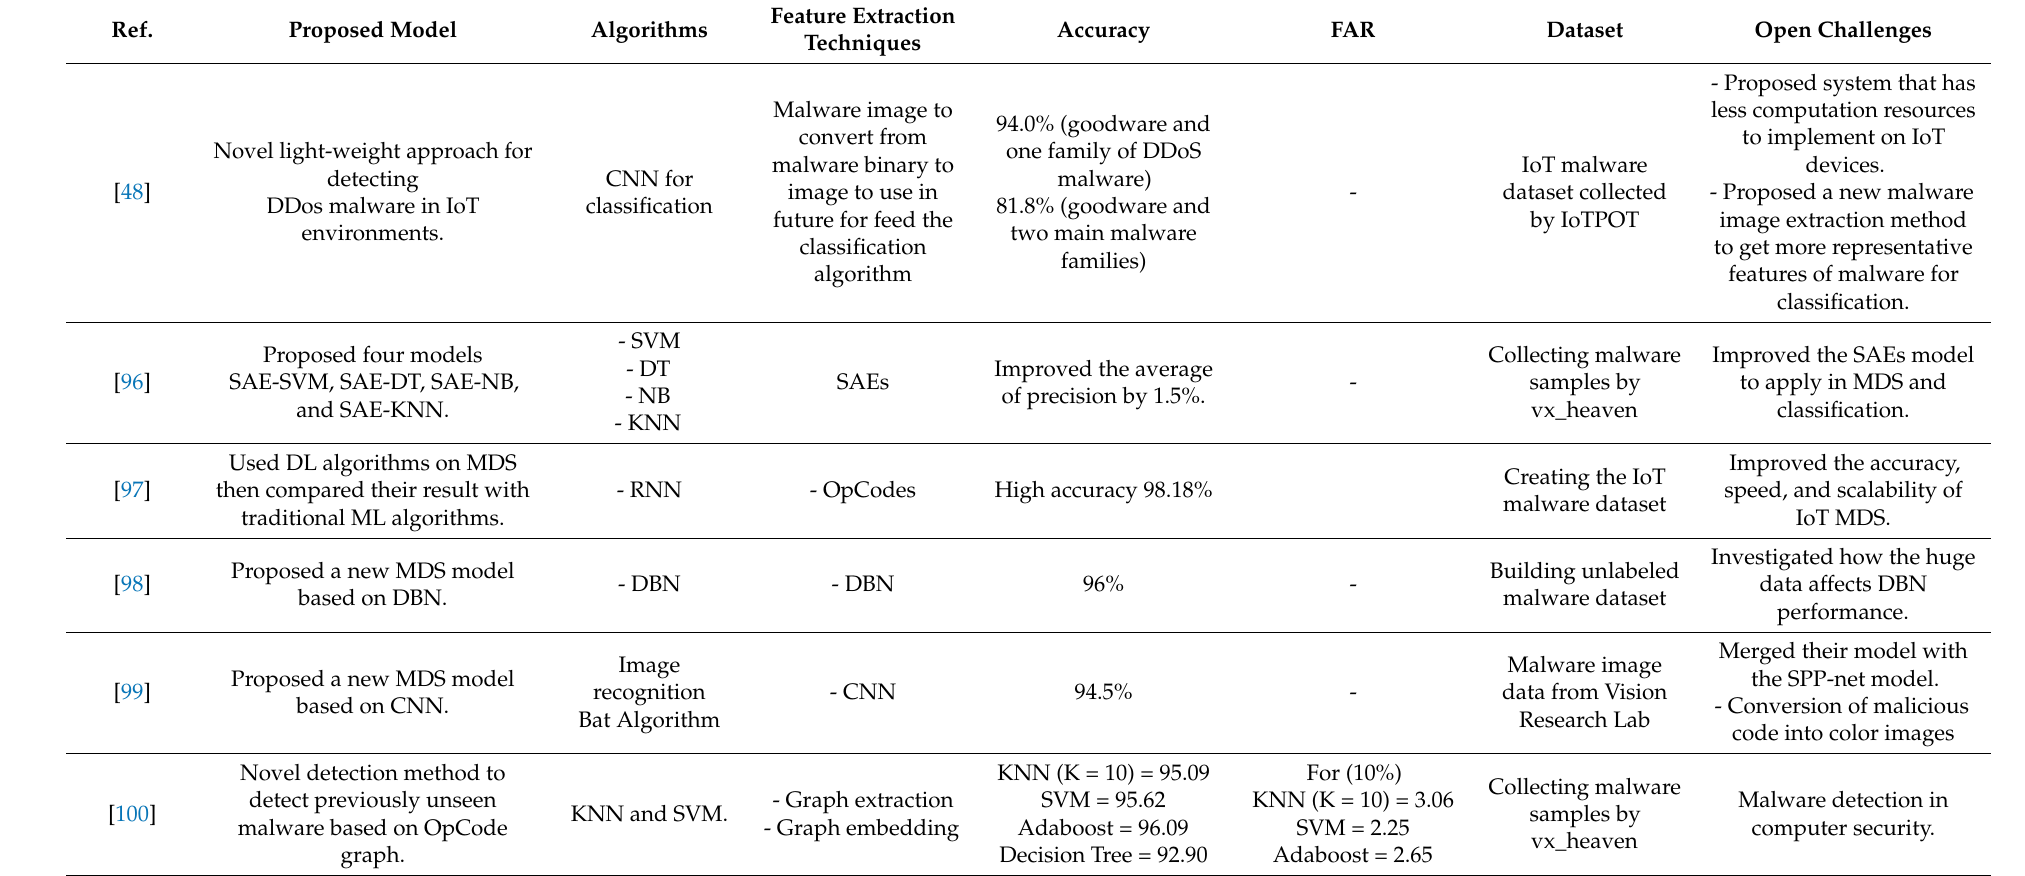
Table 6. Comparison between studies related to IoT MDS based on DL